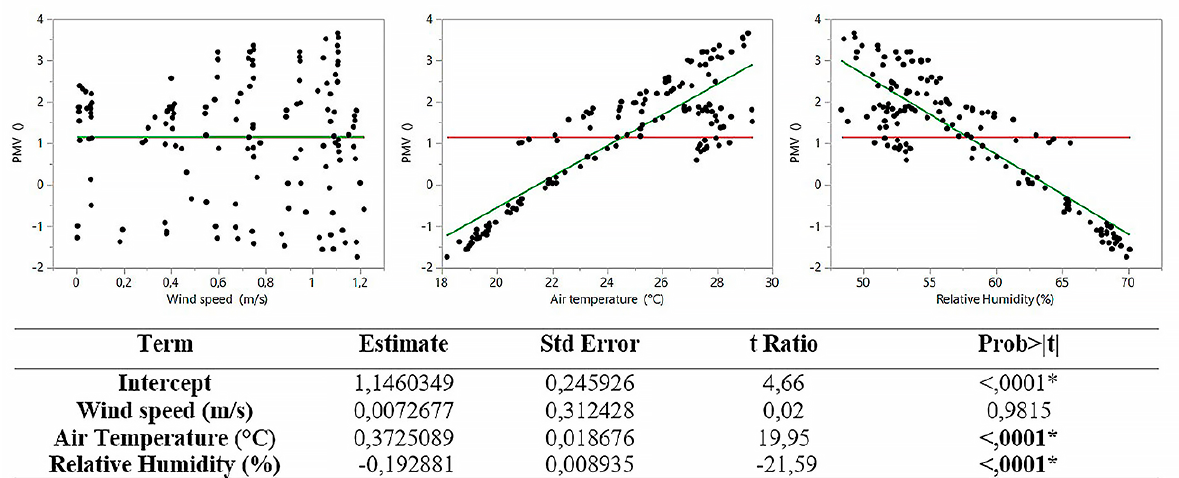
Figure 6. Regression value between PMV and other thermal